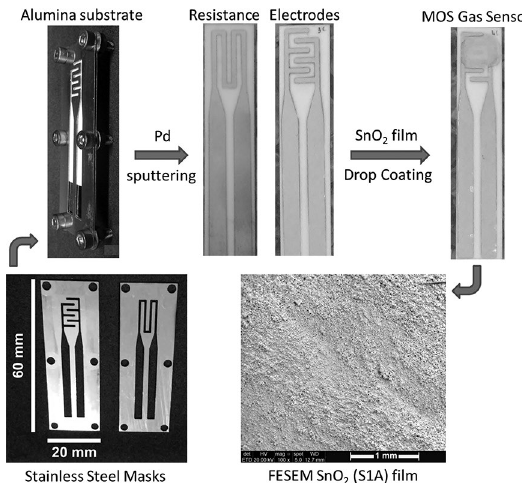
Figure 1. Production system for the sensor with stainless steel masks for sputter deposition of the heaters and platinum electrodes onto the alumina substrate and deposition of the SnO by